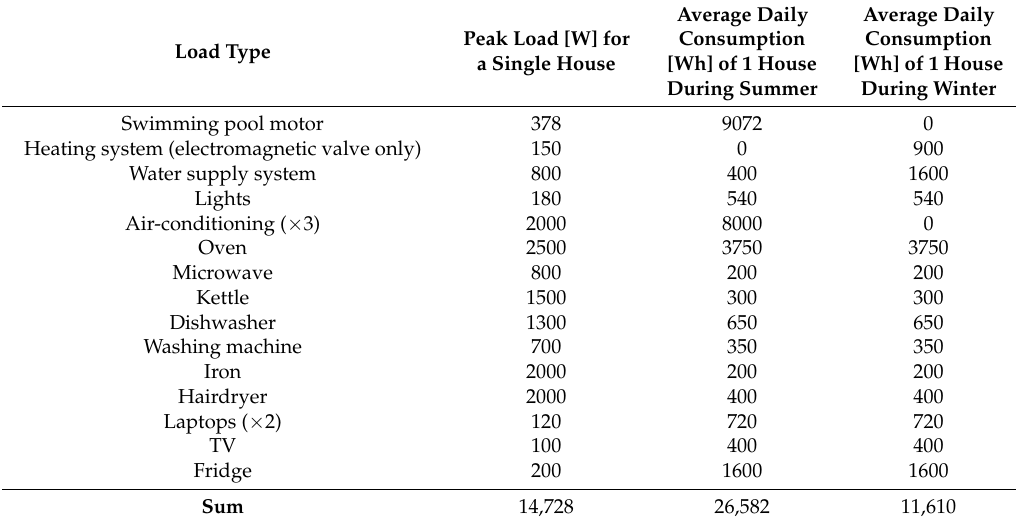
Table 1. Load types and estimated daily consumption figures.